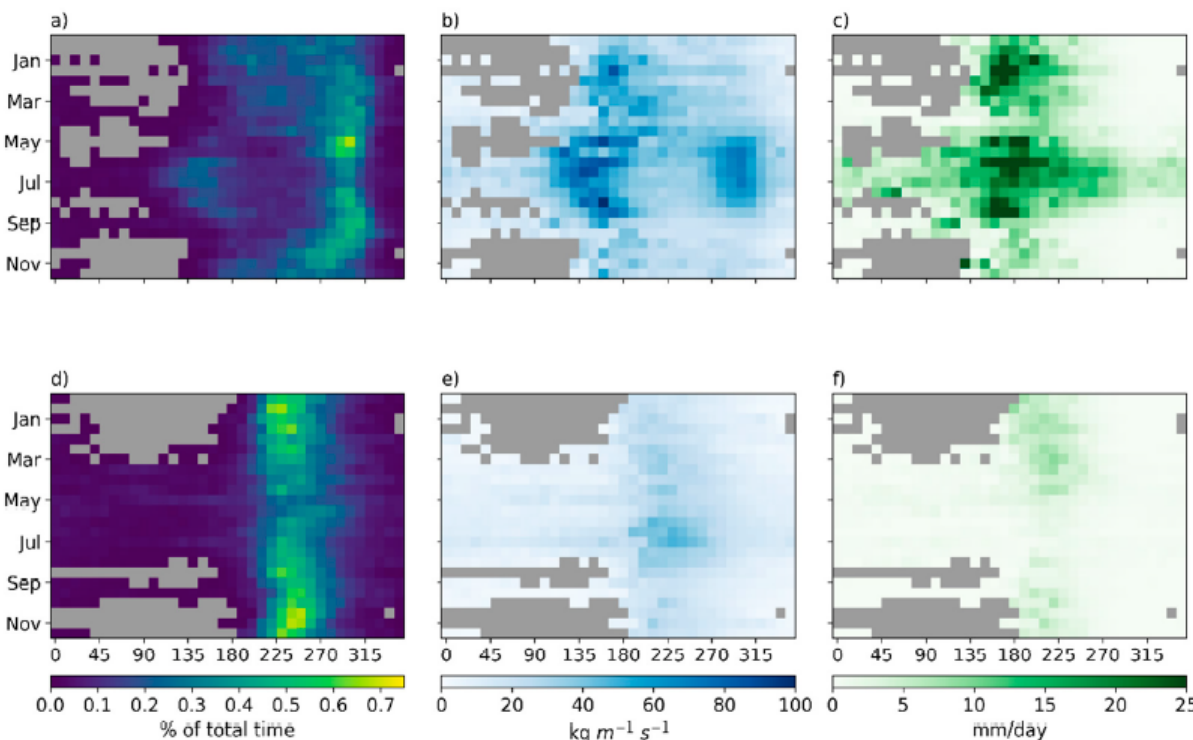
Figure 8. Vector-mean IVT direction frequency ( a , d ), vector-mean IVT magnitude ( b , e ), and mean precipitation amount ( c , f ) in the Western Himalaya ( a – c ) and Karakoram ( d – f ) subregions as a function of time of year ( y -axis) and IVT direction ( x -axis) to show the relationship between moisture source direction, IVT magnitude, and precipitation. All panels are calculated from hourly values; cells with less than 10 occurrences over the 15-year period excluded (grey regions). The Karakoram and western Himalaya subregions of focus here are outlined as black boxes in Figures 3, 6 and